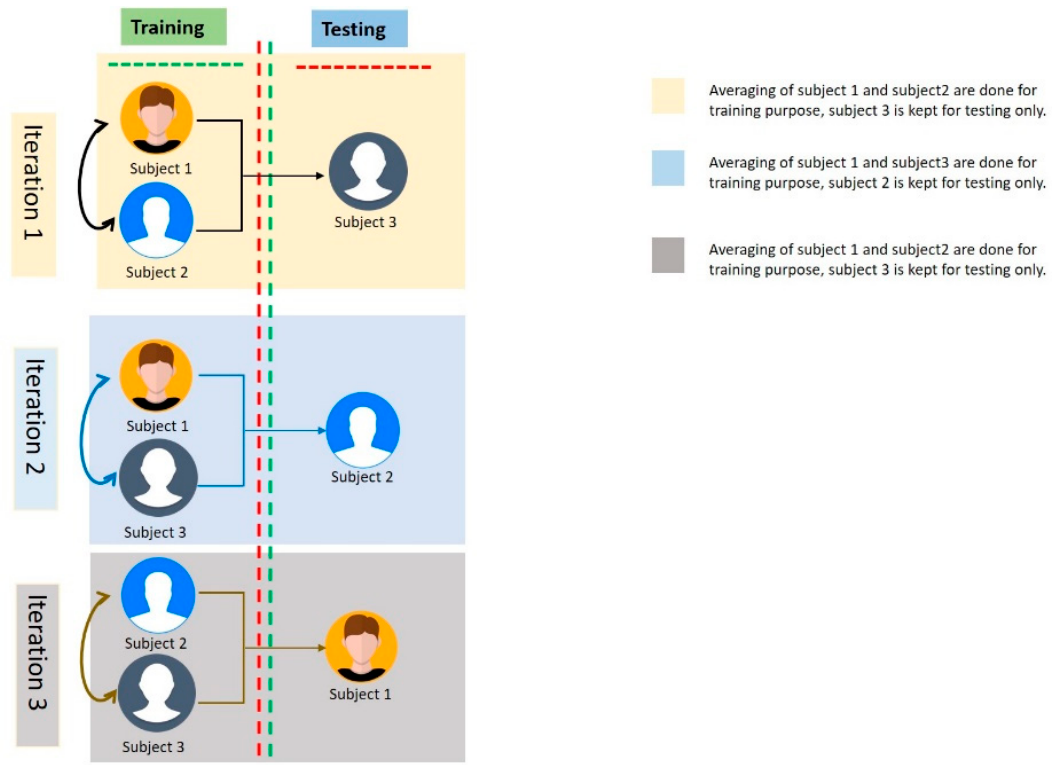
Figure 4. Illustration of how different subjects were considered for training and testing purposes. training phase.